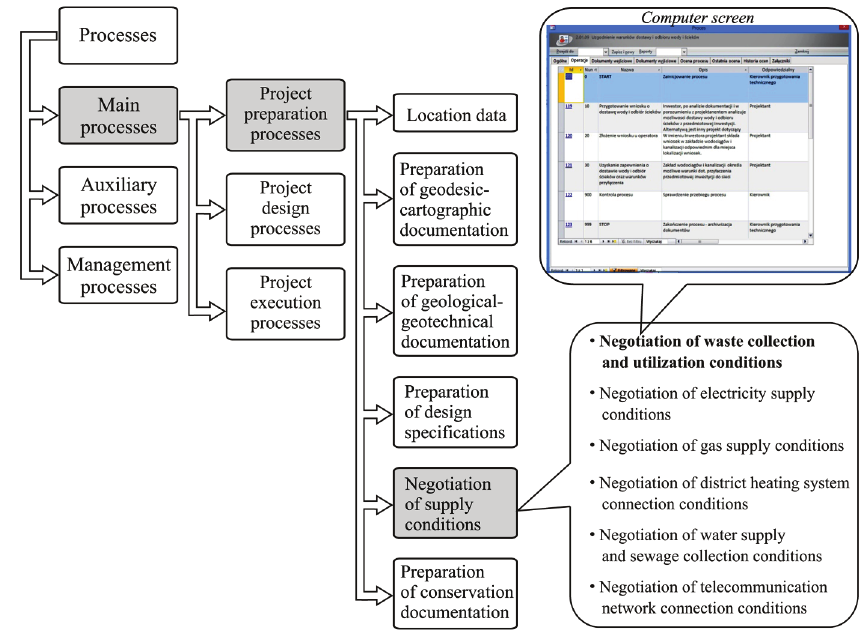
Fig. 6. an expansion of the knowledge element “Main